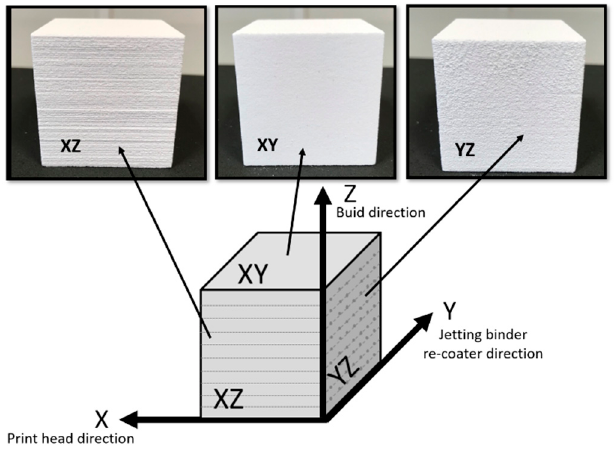
Figure 10. Directions and surface structures of the printed specimens with the Project 660 Pro machine.